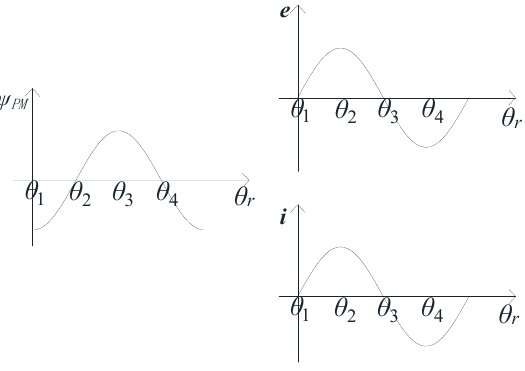
Figure 3. Waveforms of PM flux linkage, no-load back-EMF, and phase current.